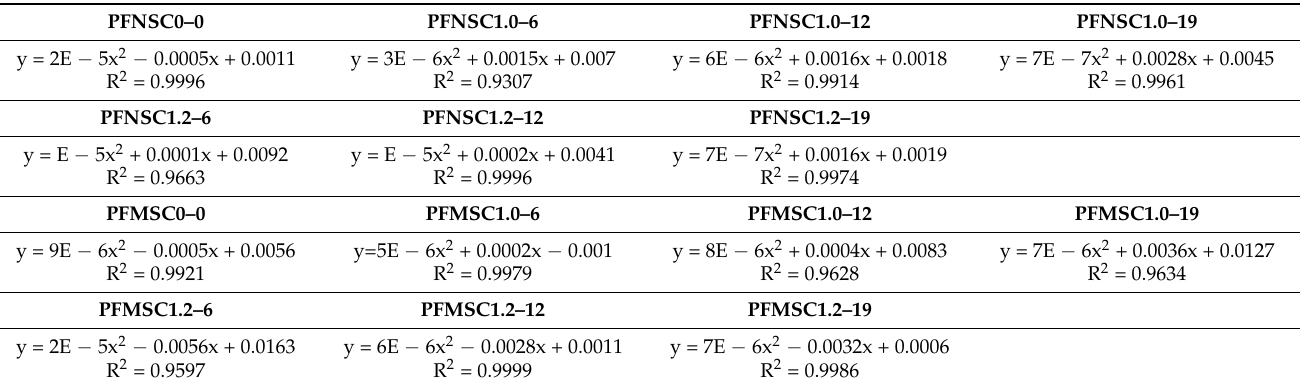
Table 4. Fit function of compressive strength damage value.